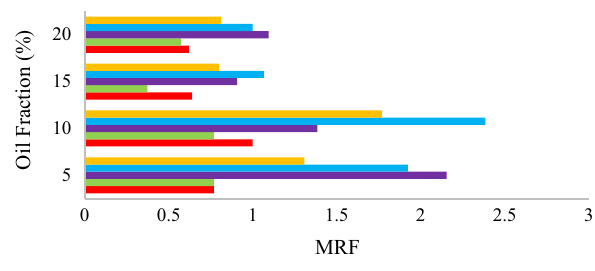
Fig. 9 Calculated MRF at different oil fractions, and at 100